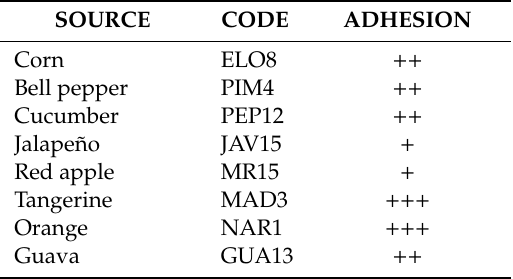
Table 4. Adhesion activities of Lactic acid bacteria selected due to their multiple enzymatic activities showed.